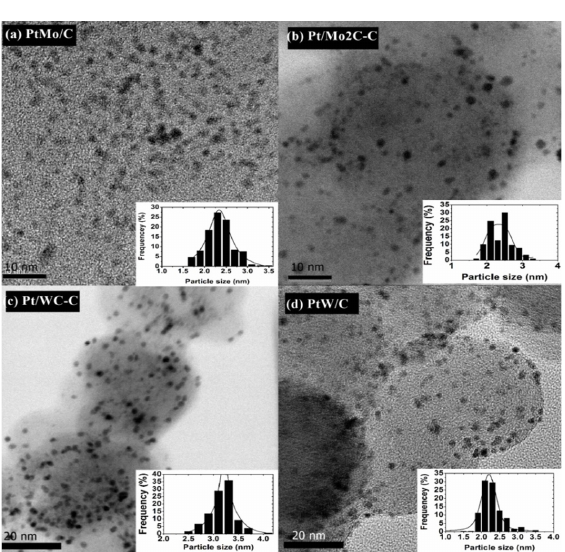
Figure 2 - TEM images of different anode catalysts; insets: corresponding histograms based on collection of 200